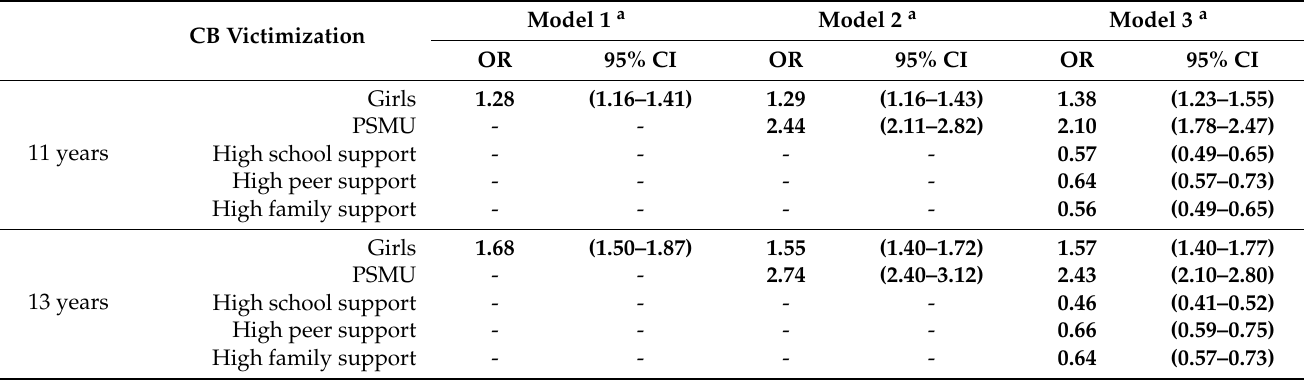
Table 2. Odds ratio (OR) and 95% confidence interval (CI) for cyberbullying victimization, by age, gender, PSMU, and social support (school peers and family); Italian HBSC